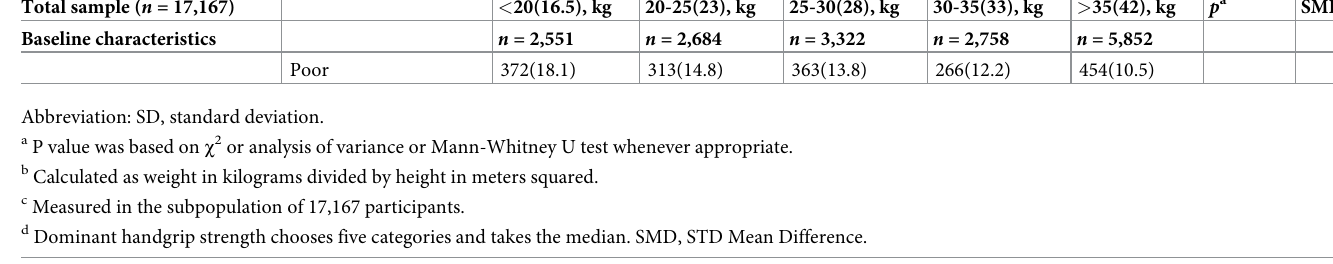
Data were fitted by a restricted spline Cox proportional hazard regression model (Fig 2). A lin- ear relationship existed between grip strength and death (for nonlinearity, P = 0.293). We selected the median grip strength as the reference point. The risk of all-cause death was rela- tively flat until around 34.2 kg of handgrip strength ( HR = 0.92, 95% CI : 0.85–1.00).